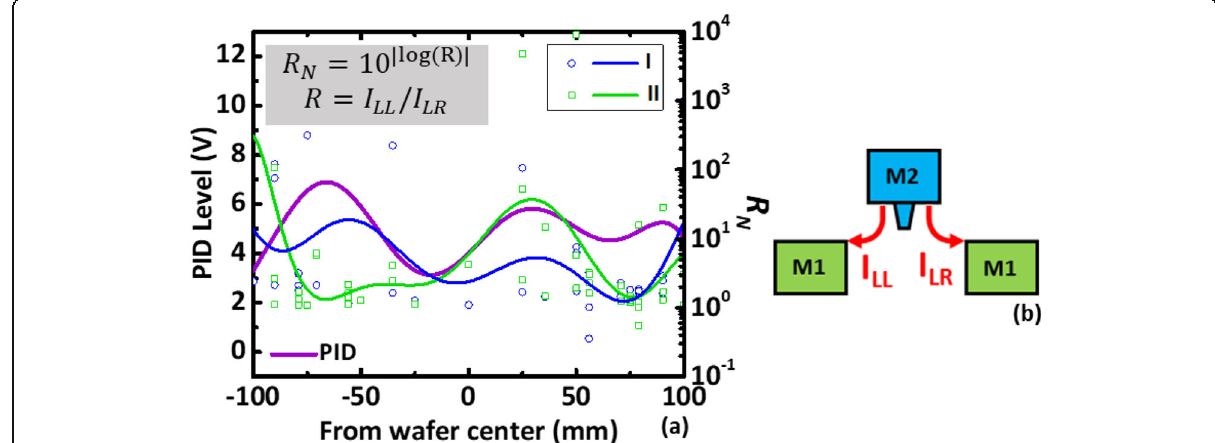
Fig. 9 a Normalized current ratios from pattern I and II samples across wafer center as compared to the corresponding PID levels and b the definition of leakage current on the left ( I LL ) and right ( I LR